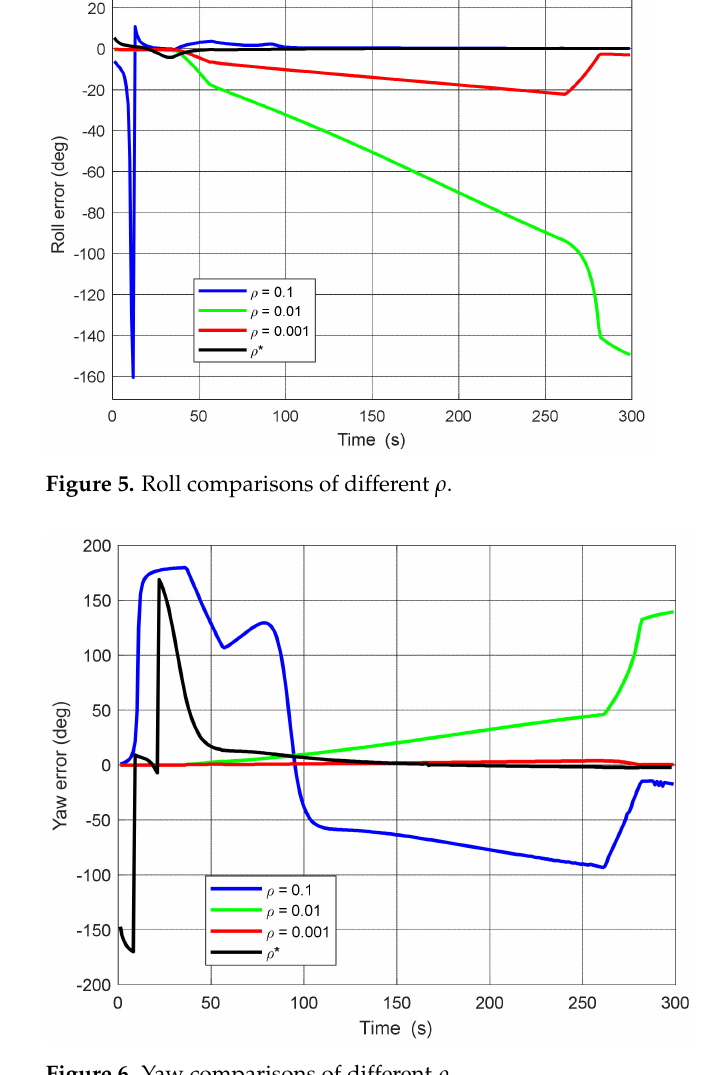
Figure 6. Yaw comparisons of different ρ